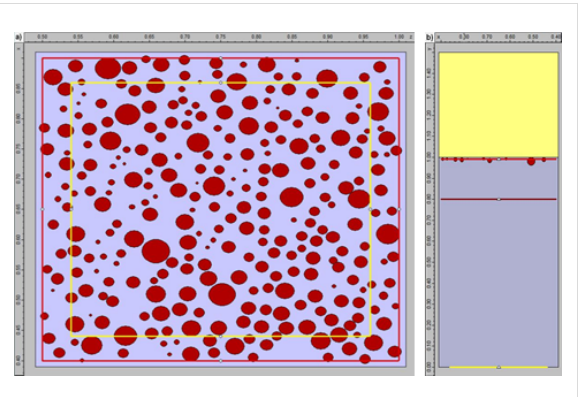
Figure 12: Setup for the FDTD and FDTD/DFT simulations. Left: view from the bottom, zx -plane; yellow rectangle – outer border of the light source; red rectangle – outer border of the sensors; brown circles – gold nanoparticles. Right: Side view, xy -plane; vellow line – light source, wave propagation in upward direction; red and brown lines – sensors for FDTD and FDTD/DFT simulation sets, respectively; light- blue area – air; yellow area – silicon; brown circles – gold nanoparti-